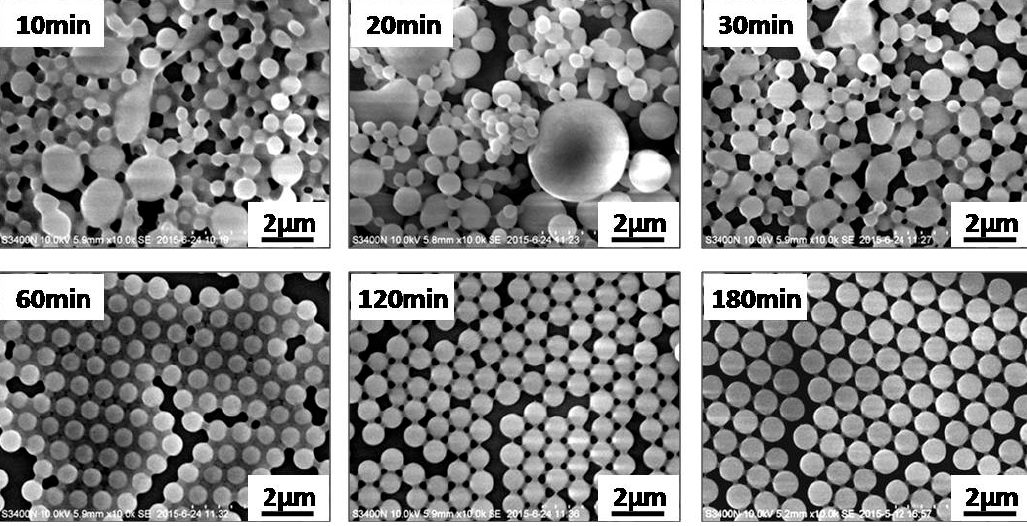
Figure 3. SEM images of polymeric microspheres prepared by photoinitiated RAFT dispersion copolymerization of MMA and MAA (in the presence of 2 wt % MAA) at different irradiation times.